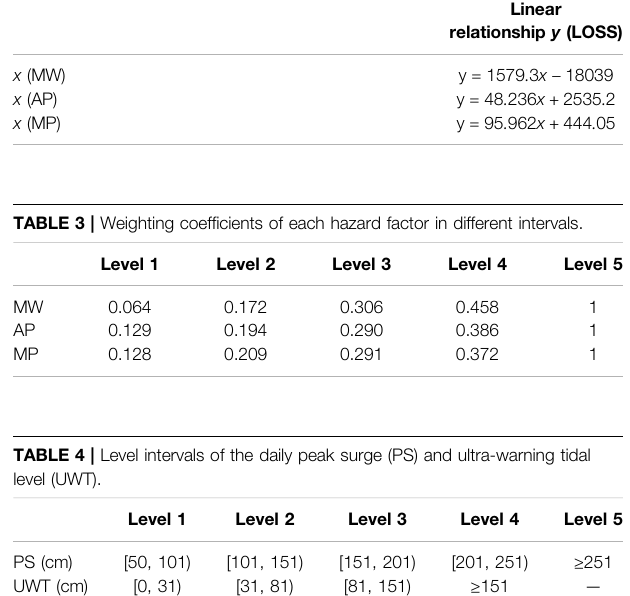
Linear relationship y (LOSS)